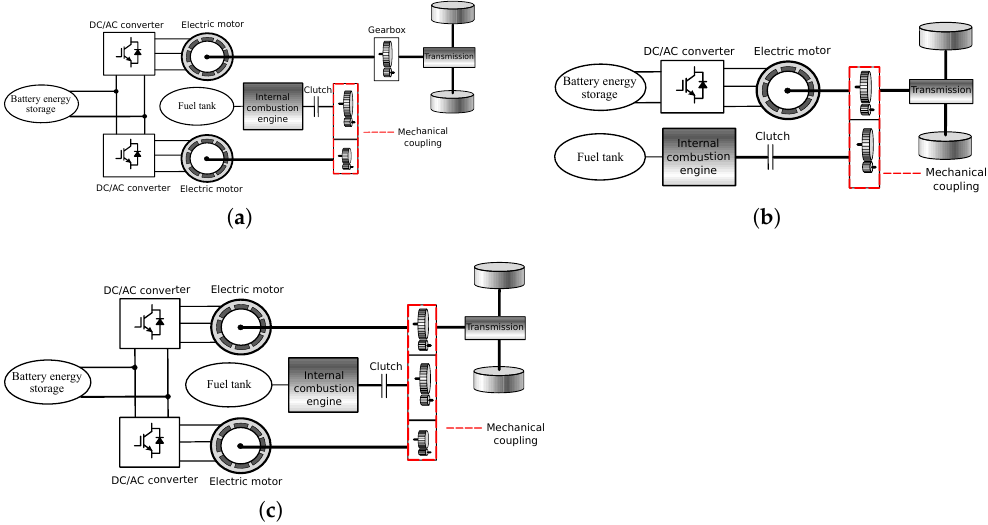
Figure 6. Full hybrid vehicles classification. ( a ) Series hybrid vehicle. ( b ) Parallel hybrid vehicle. ( c ) Parallel–series hybrid